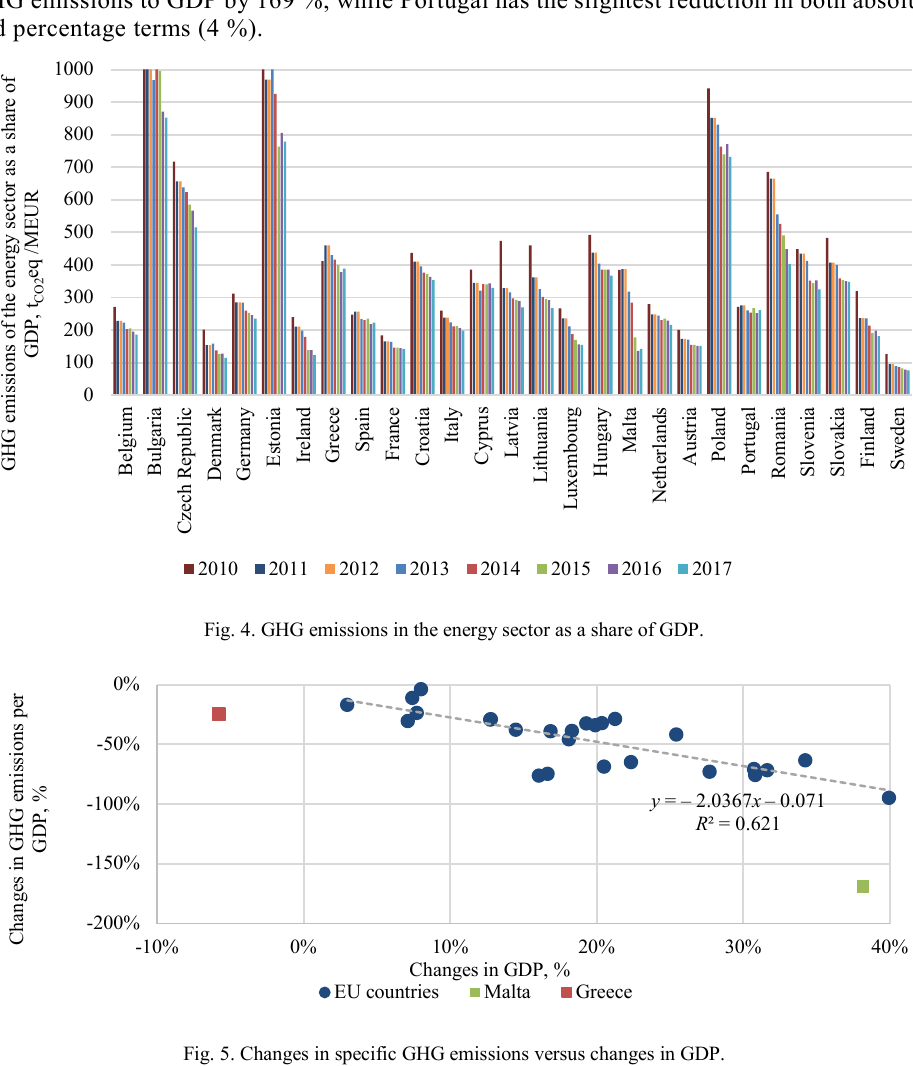
Fig. 5. Changes in specific GHG emissions versus changes in